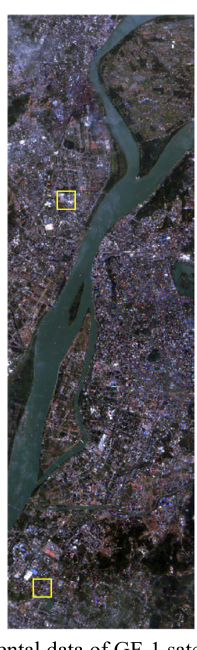
Figure 5. Experimental data of GF-1 satellite and its random areas which will be zoomed in on display